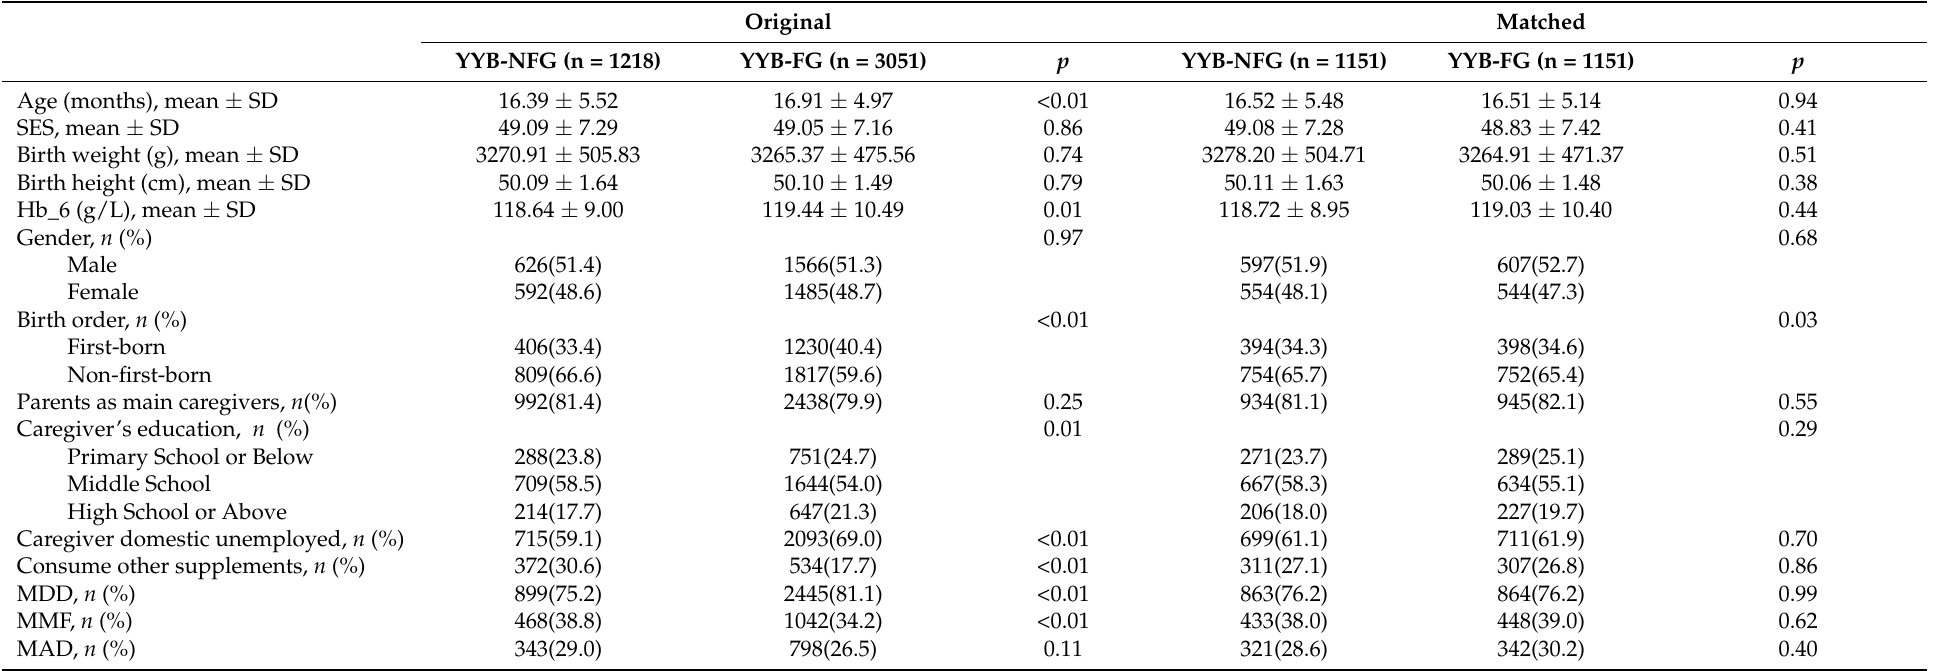
Table 1. Characteristics of infants and young children in the original and matched